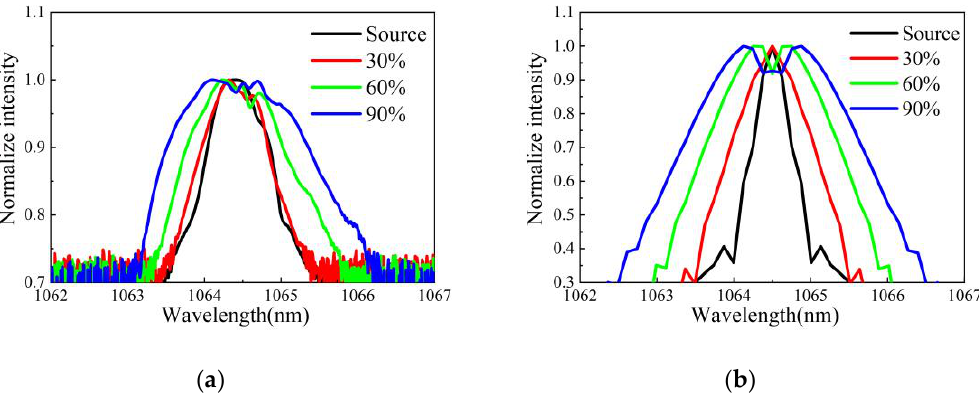
Figure 11. Output spectrum of ( a ) experiment and ( b ) simulation at the same input pulse parameters.